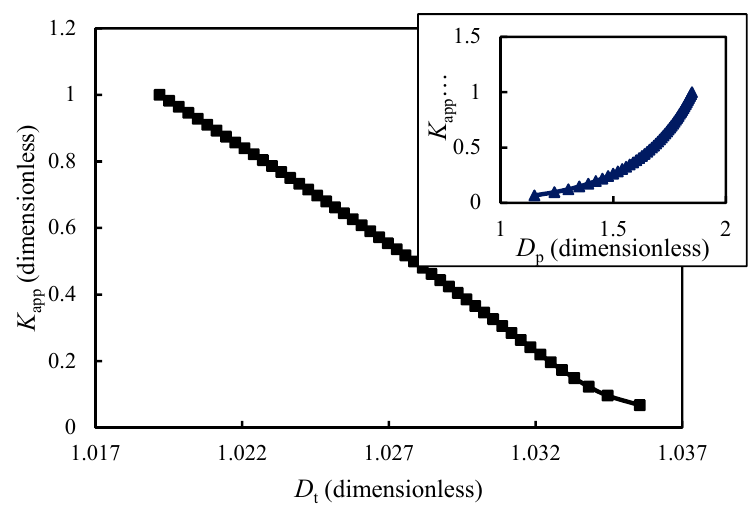
Figure 7. Effect of fractal dimension on dimensionless apparent permeability.